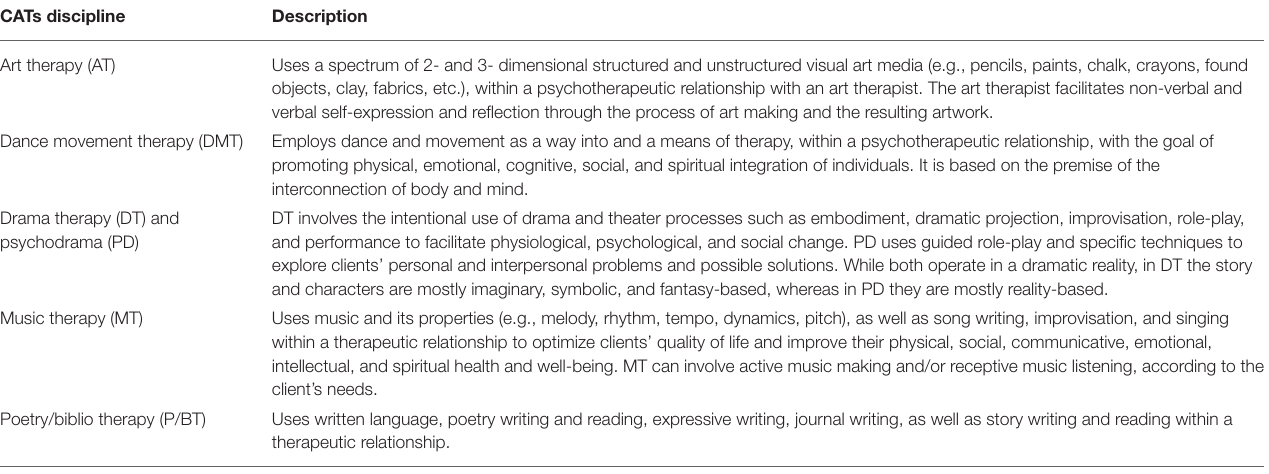
TABLE 1 | Description of each CAT discipline. CATs